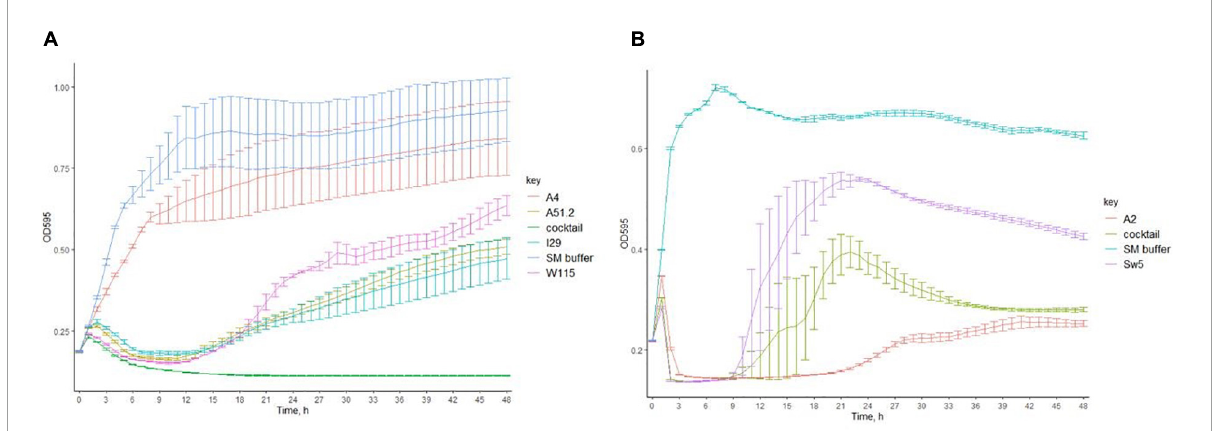
FIGURE3 The ability of (A) Escherichia phages (MOI of 0.5) and (B) Enterococcus phages (MOI of 0.2) individually or in cocktails to inhibit the formation of phage resistant of E. coli LF82 and E. faecalis OG1RF (bars represent mean ±